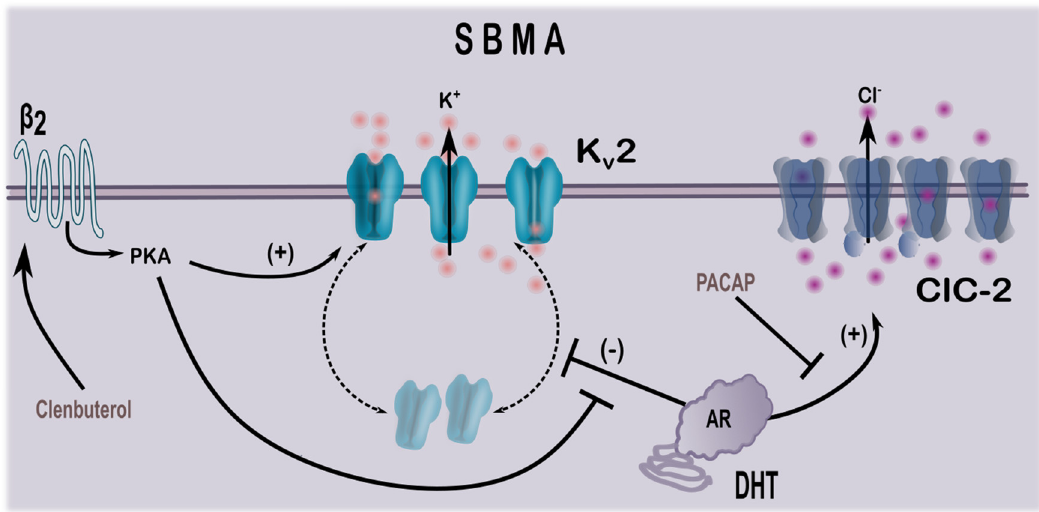
Figure 2: Signaling pathways, among other mechanisms, prompted by pathological polyQ - expanded AR protein of MN - 1 cells which modify the expression and/or activity of, at least, K V 2 potassium and ClC - 2 chloride channels. Pharmacological intervention through beta - adre - nergic stimulation ( clenbuterol ) or PACAP restores the physiological amplitudes of K V 2 - and ClC - 2 currents, respectively. The fi nal regulation of the biophysical properties of those ion channels in SBMA MN - 1 cells could be the result of tra ffi cking and insertion into the plasmatic membrane of channels, and changes in the expression levels ( after refs [ 16,19,20 ])